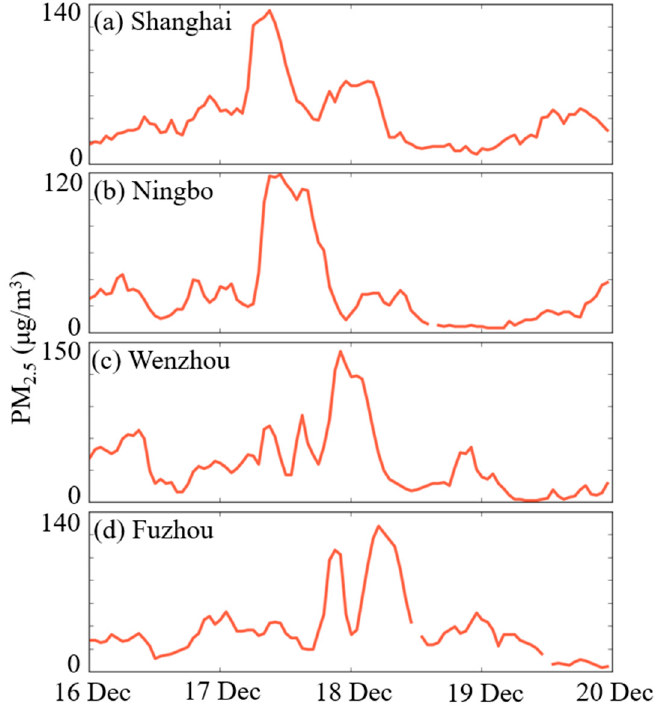
Figure 4. Time series of PM 2.5 concentrations in ( a ) Shanghai, ( b ) Ningbo, ( c ) Wenzhou, and ( d ) Fuzhou from 16 to 19 December 2019.